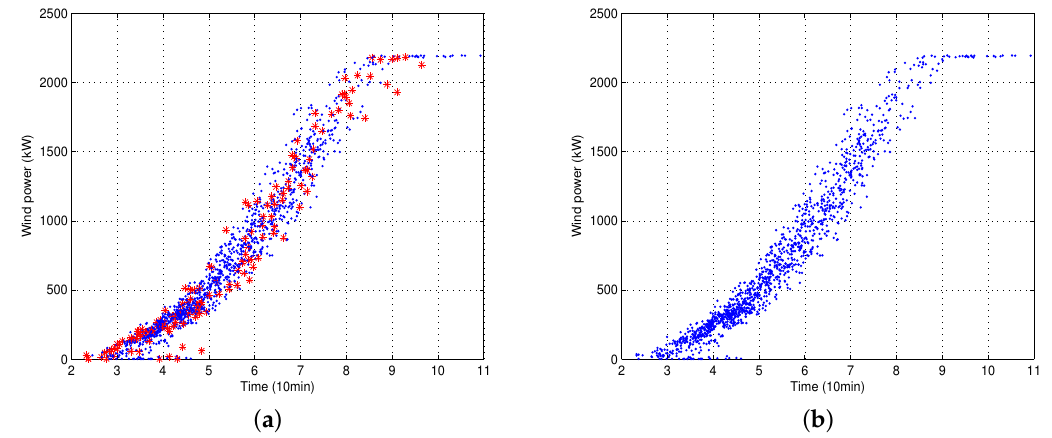
Figure 6. The empirical wind power time series processed by DBSCAN. ( a ) Abnormal data identified by DBSCAN for set A. ( b ) Modified wind power by Lagrange interpolation for set